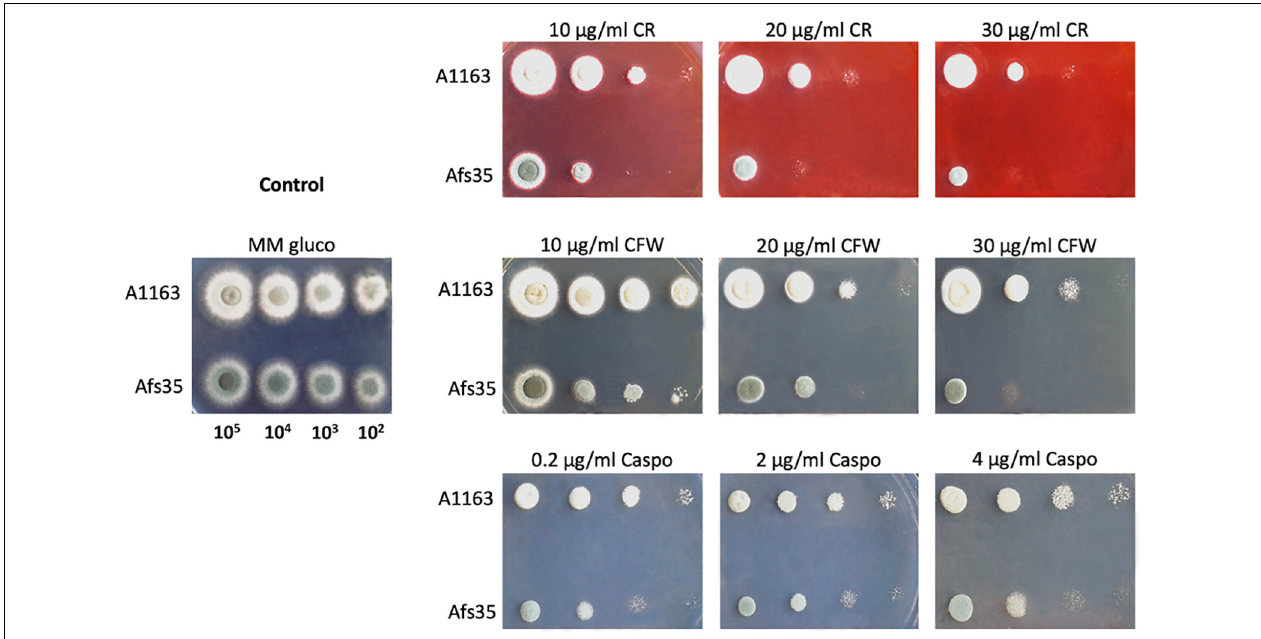
FIGURE 5 | Aspergillus fumigatus strain Afs35 is more sensitive to cell wall disturbing compounds than strain A1163. Tenfold serial dilutions of strains when grown for 48 h on MM (minimal medium) supplemented with glucose and increasing concentrations of congo red (CR), calcofluor white (CFW) and caspofungin